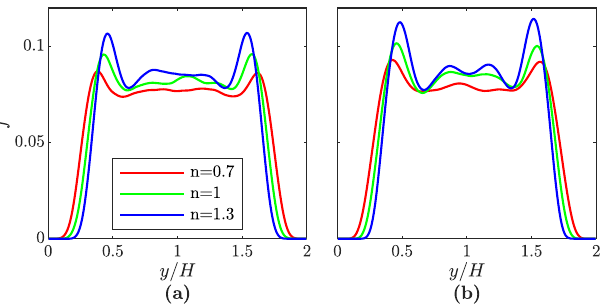
Figure 6. Average gas volume fraction field f as a function of the wall-normal coordinate for the two-phase setups with Eo = 0.3125 ( a ) and Eo = 3.75 ( b